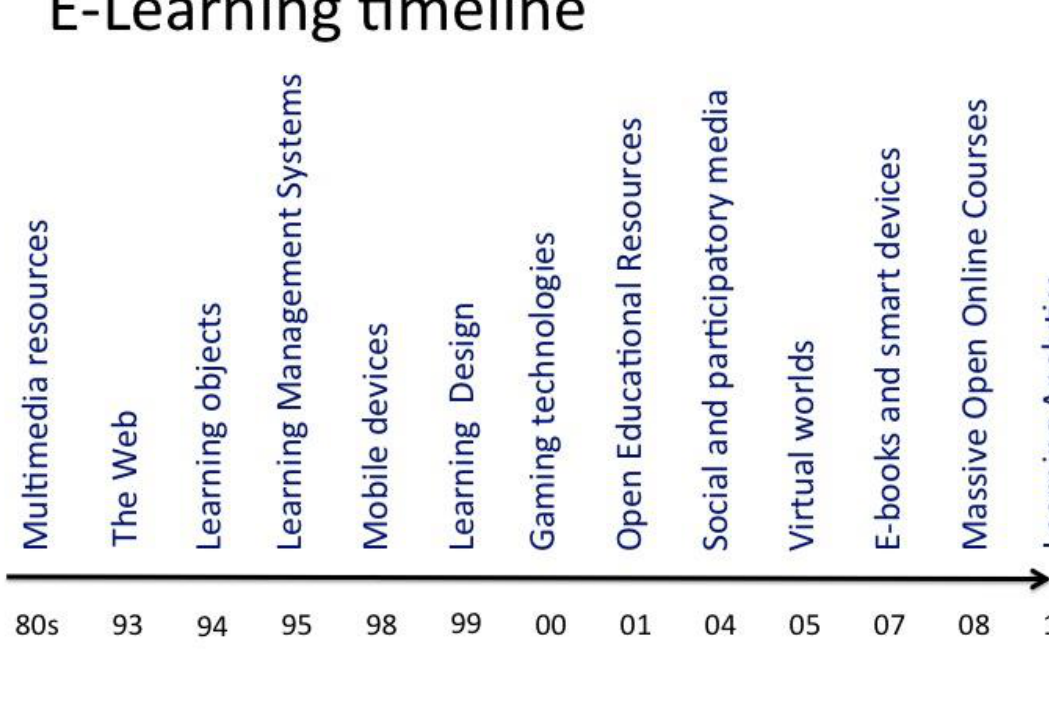
Figure 1: An e-learning timeline of transformative technologies